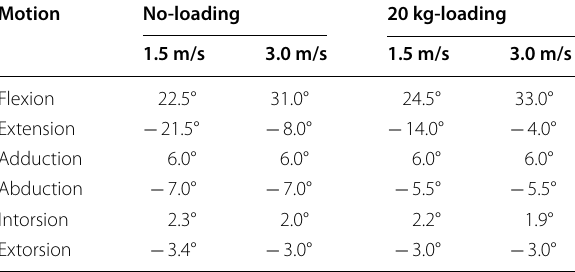
Table 1 Ultimate angles of the hip in multi‑modes